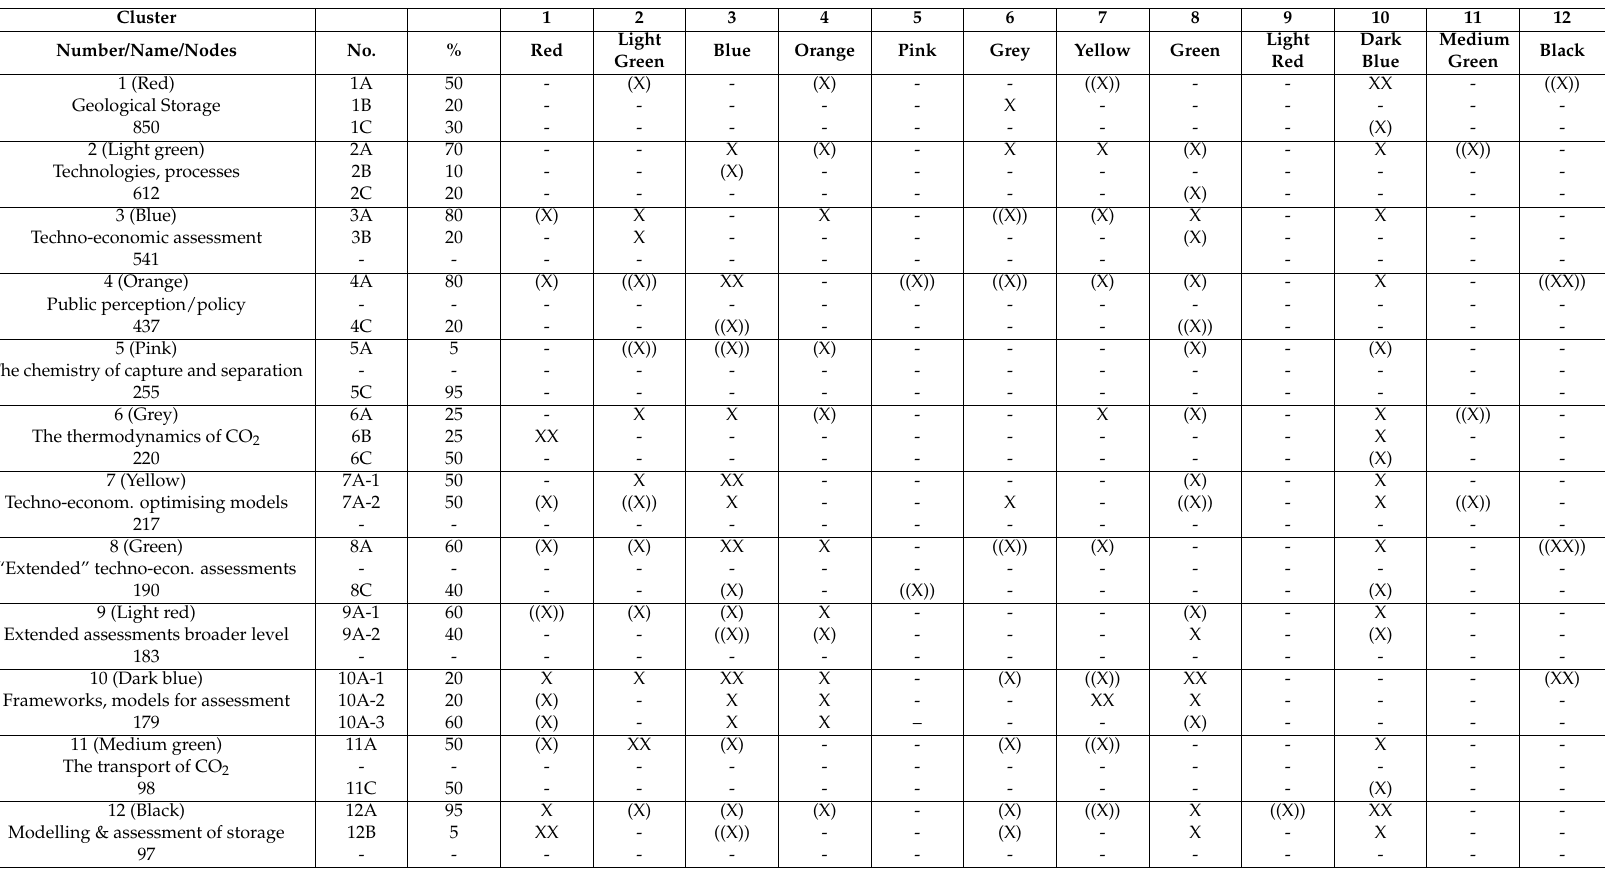
Table A3. Main relationships between clusters (conceptional model). Papers that have similar target clusters are grouped into a sub-cluster. Sub-clusters (A) contain papers that are linked to several clusters located in the direct or indirect neighbourhood (close to the network centre), sub-clusters (B) encompass papers linked to one or two selected neighbouring clusters, and sub-clusters (C) mostly link papers from the same cluster (located at the network’s border). The third column shows the (estimated) share of each sub-cluster. Evaluation symbols: XX: very strong connection X: strong connection (X): little connection ((XX)): very little